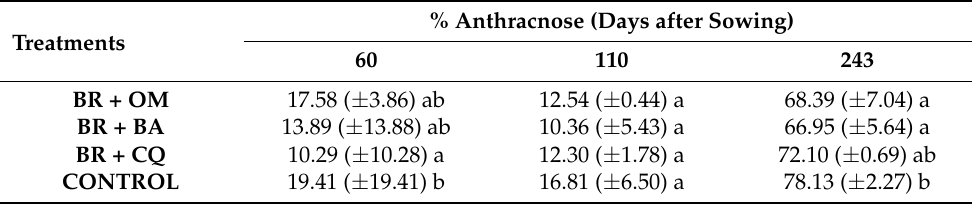
Table 7. Effect of treatments on the percentage of Anthracnose disease.